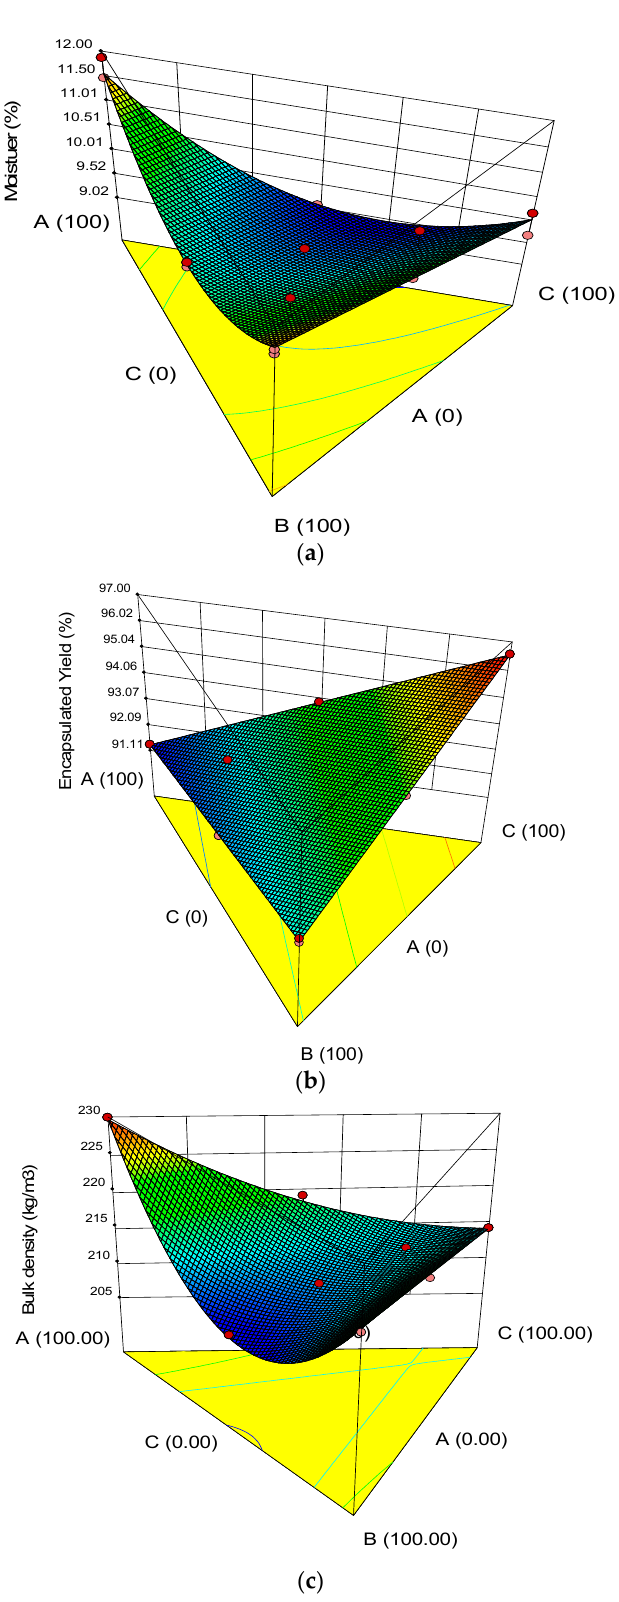
Figure 1. Estimated response surface plots indicating effect of sodium caseinate (SC), pectin (P), and whey protein isolate (WPI) levels on physical parameters: ( a ) Moisture, ( b ) Encapsulation Yield, ( c ) Bulk Density.